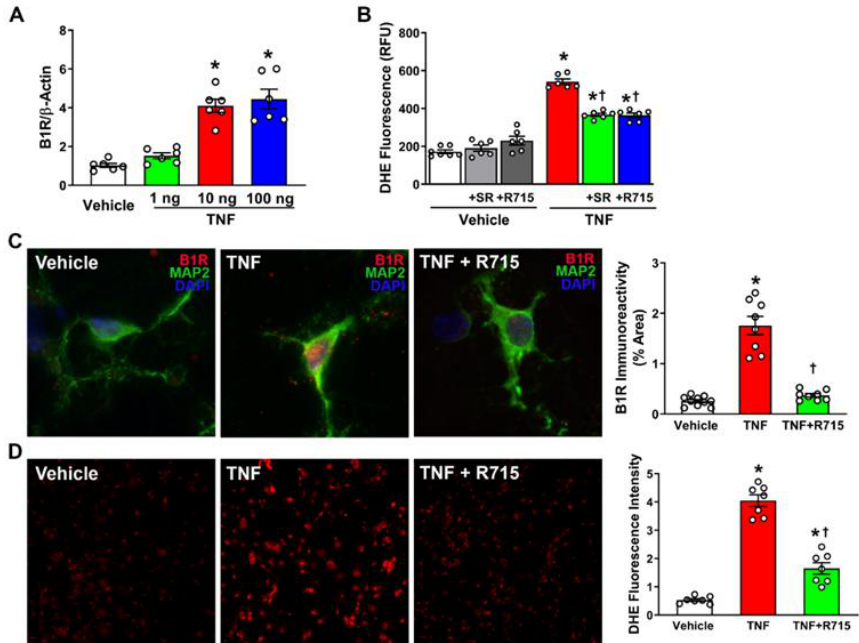
Figure 2. TNF treatment on primary hypothalamic neurons. ( A ) B1R mRNA levels in cultured neurons, measured by real time PCR (n = 6 independent cultures/group). ( B ) ROS generation indicated by microplate DHE assay (n = 6–7/group). ( C ) Quantification and immunofluorescent images of B1R expression (n = 8–10/group). ( D ) ROS production and quantification of DHE staining (n = 7/group). Statistical significance: One-way ANOVA followed by Tukey’s multiple comparisons test. * p < 0.05 compared to vehicle. † p < 0.05 compared to TNF.